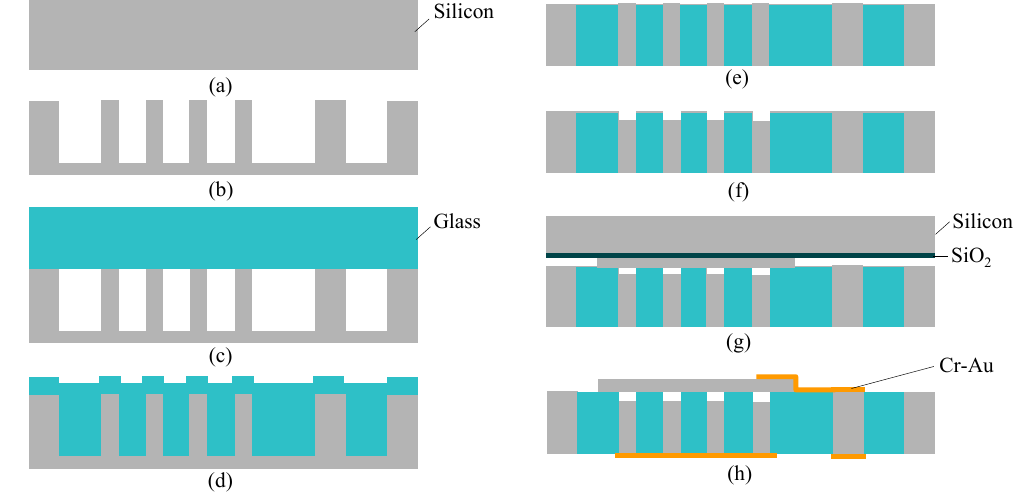
Figure 3. Fabrication process. ( a ) Silicon wafer; ( b ) Photolithography and deep RIE; ( c ) Anodic bonding in vacuum chamber; ( d ) Glass reflow process; ( e ) Lapping and polishing; ( f ) Photolithography and deep RIE; ( g ) Anodic bonding in vacuum chamber; ( h ) Silicon and SiO 2 removal, electrical connection and contact